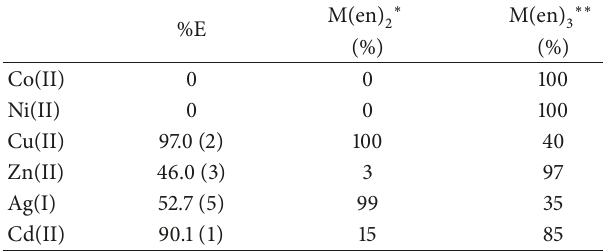
Table 1: Extraction percentage (Ex%) of the transition metal ions with H 8 L from ethylene diamine into dichloromethane at 25 ∘ C and distribution ratio of M(en) 2 and M(en) 3 in the aqueous phase before extraction. Uncertainties are given in parentheses as standard errors of the mean (N =